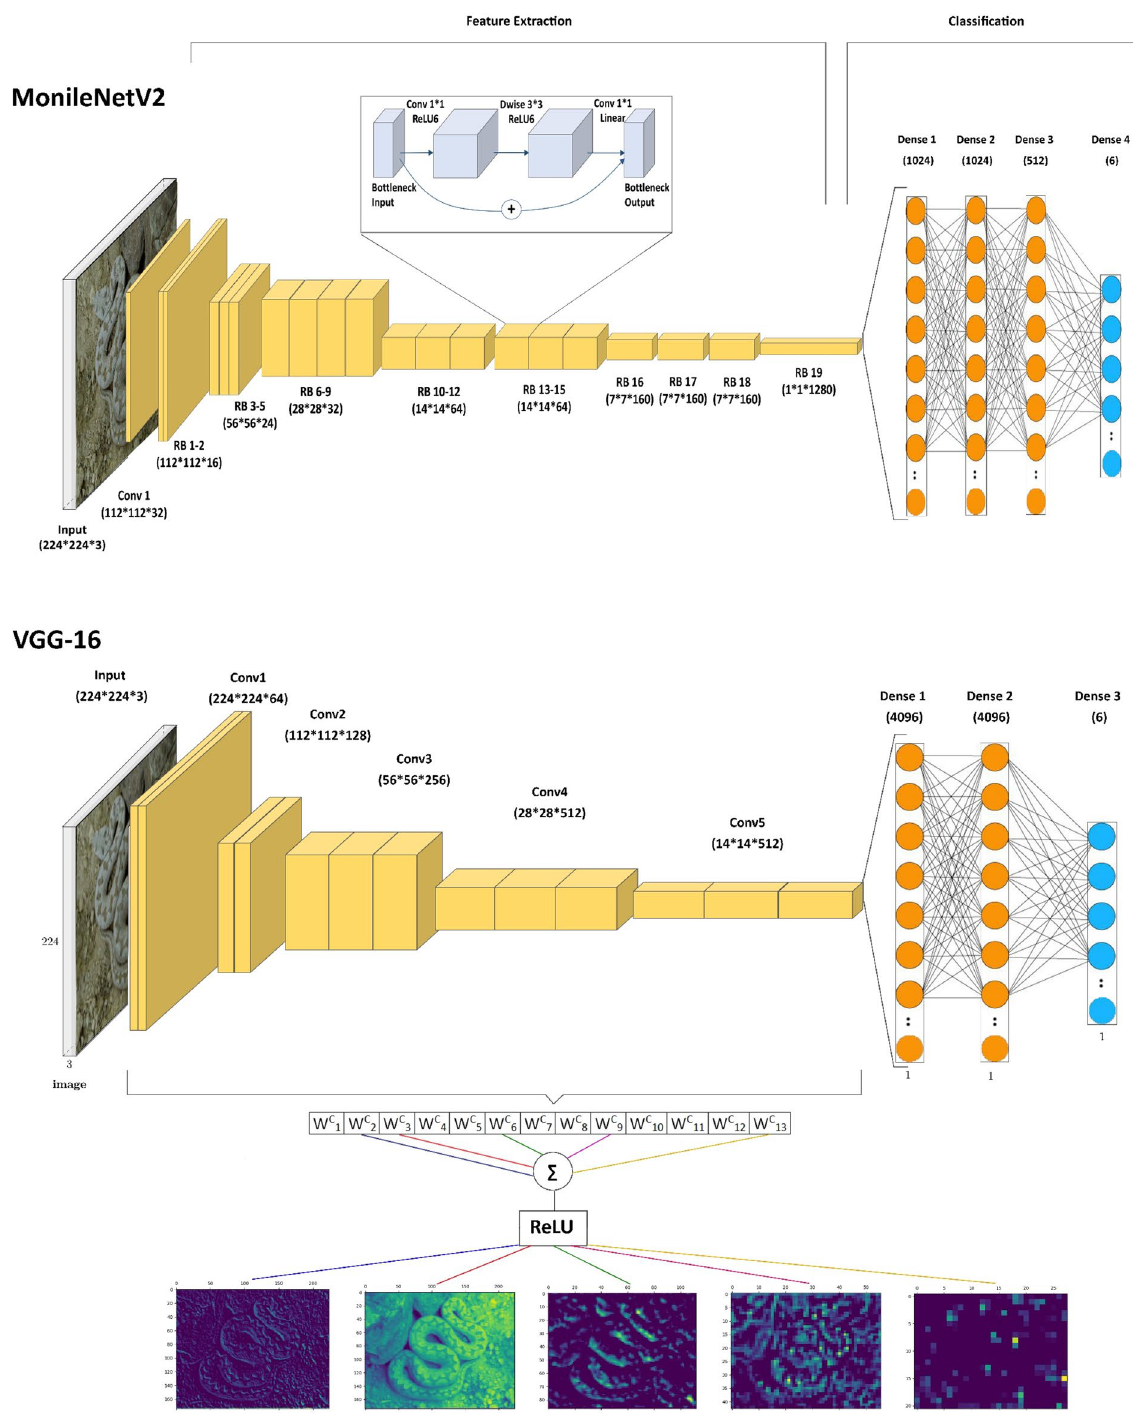
Figure 11. Architecture of the MobileNetV2 and the VGG-16 deep convolutional neural network 37 (the image modified from 42 ) as well as the process of visualization of hidden activation layers. Cov convolutional layer, RB residual bottleneck layer. Max pooling layers did not show to simplify the